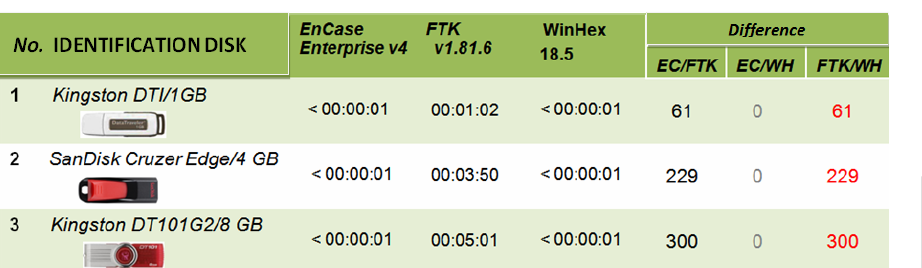
Table 2 – Display of the values obtained by testing the digital forensics software: EnCase, FTK and WinHex, in terms of the time required to identify disks of 1, 4 and 8 GB Таблица 2 – Изображение значений , полученных путем тестирования программного обеспечения цифровой форензики EnCase, F ТК и WinHex, с учетом времени , необходимого для идентификации накопителя 1, 4 и 8